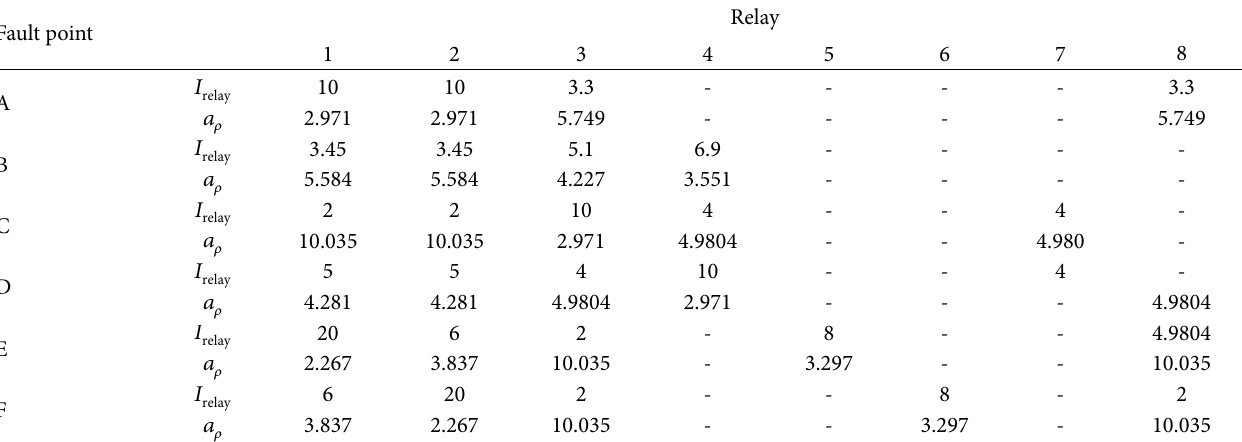
Table 8: 𝑎 Constants and relay currents for Case 2. 𝜌